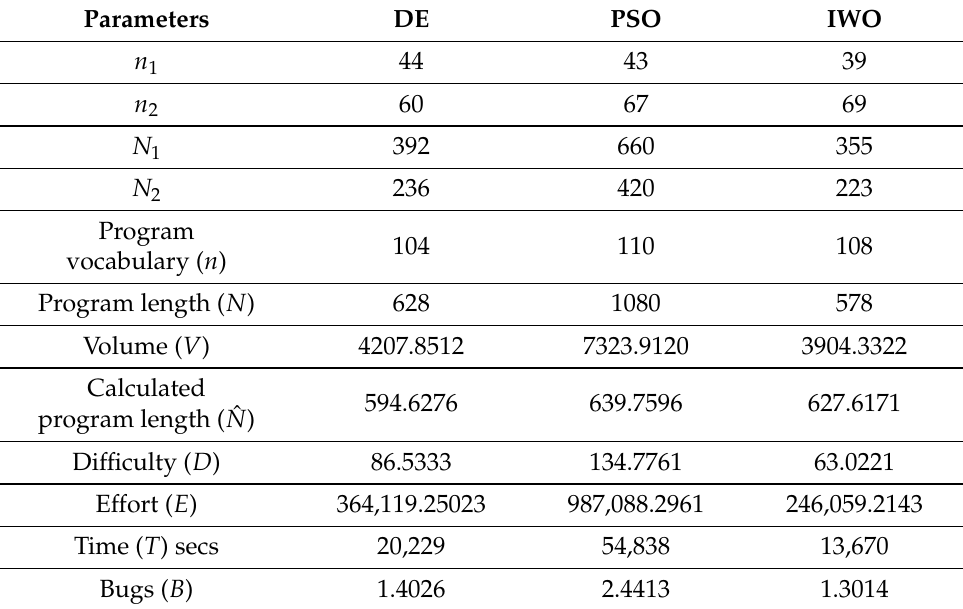
Table 3. Halstead complexity metrics for DE, PSO, and IWO.